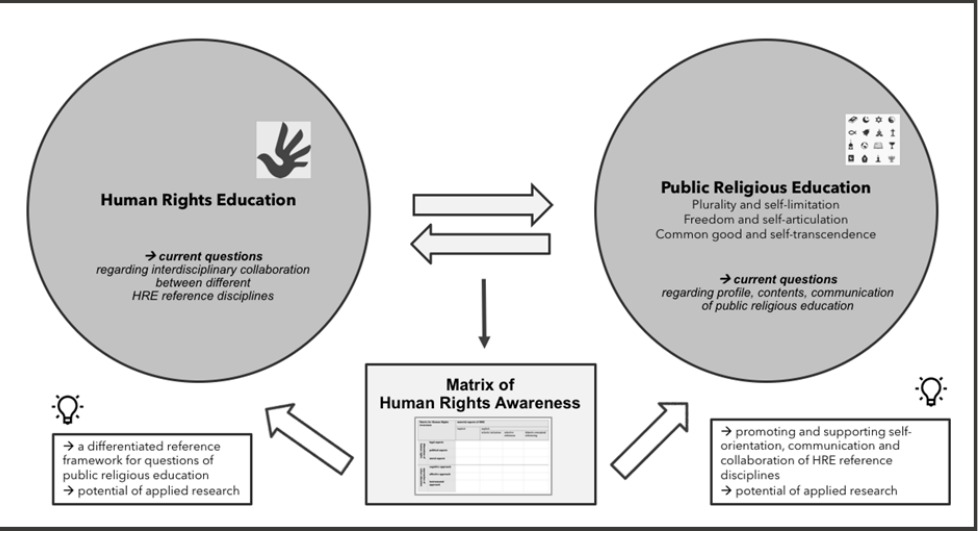
Figure 1 : Visualisation of this